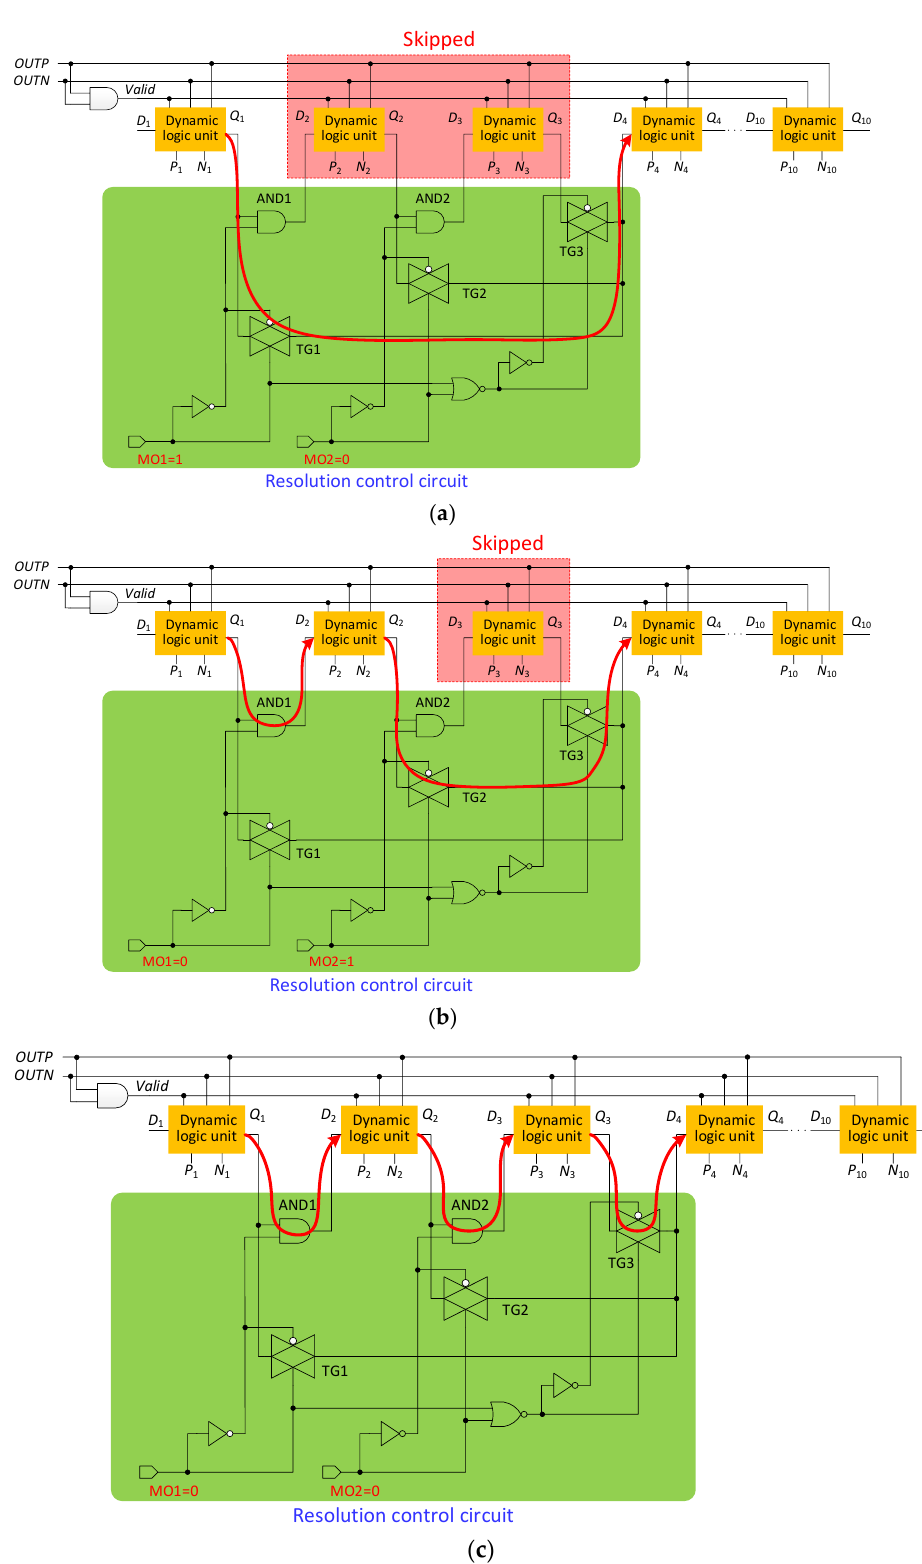
Figure 14. SAR based on dynamic logic.